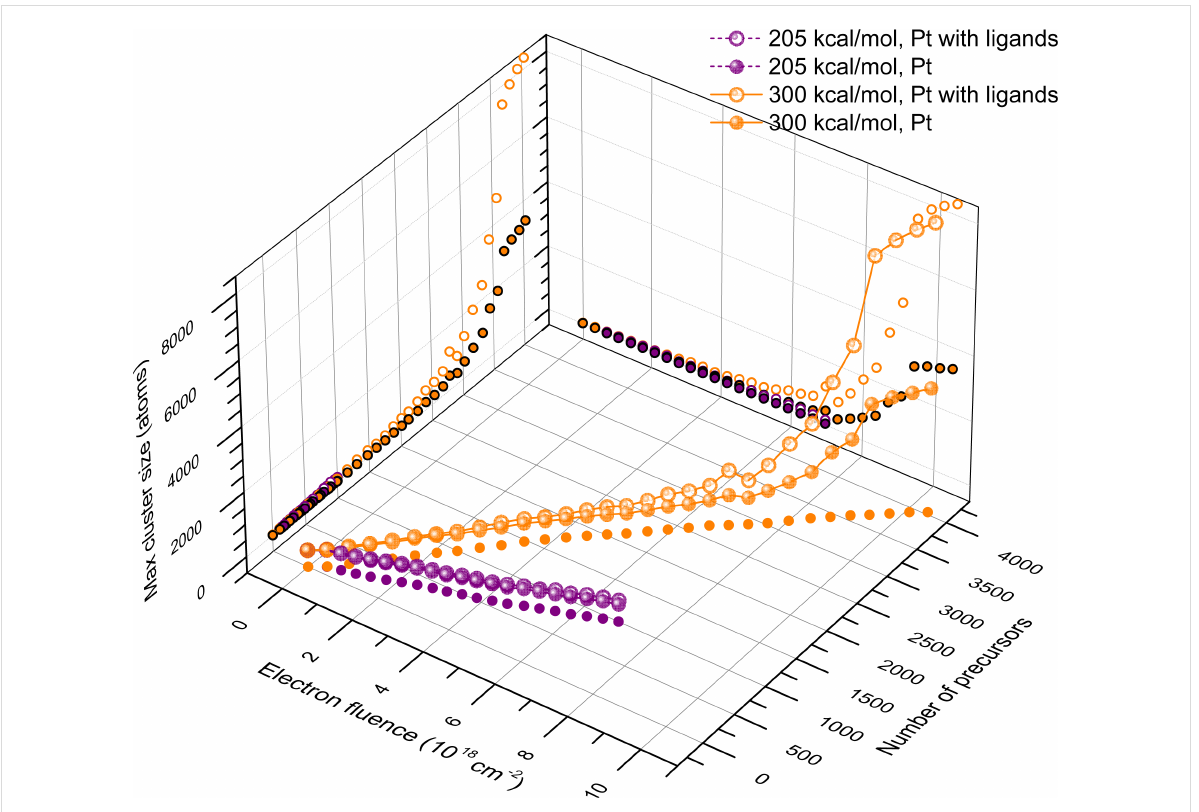
Figure 5: The number of Pt atoms (full spheres) and the total number of atoms including ligands (open spheres) in the largest cluster as functions of electron fluence and the number of adsorbed precursor molecules in the effective beam spot for energies transferred to the medium during fragmenta- tion of E dep = 205 kcal/mol (purple symbols) and 300 kcal/mol (orange symbols). Full and open dots show the respective projections on the planes. Each symbol describes the parameter values derived at the end of each consecutive FEBID cycle.